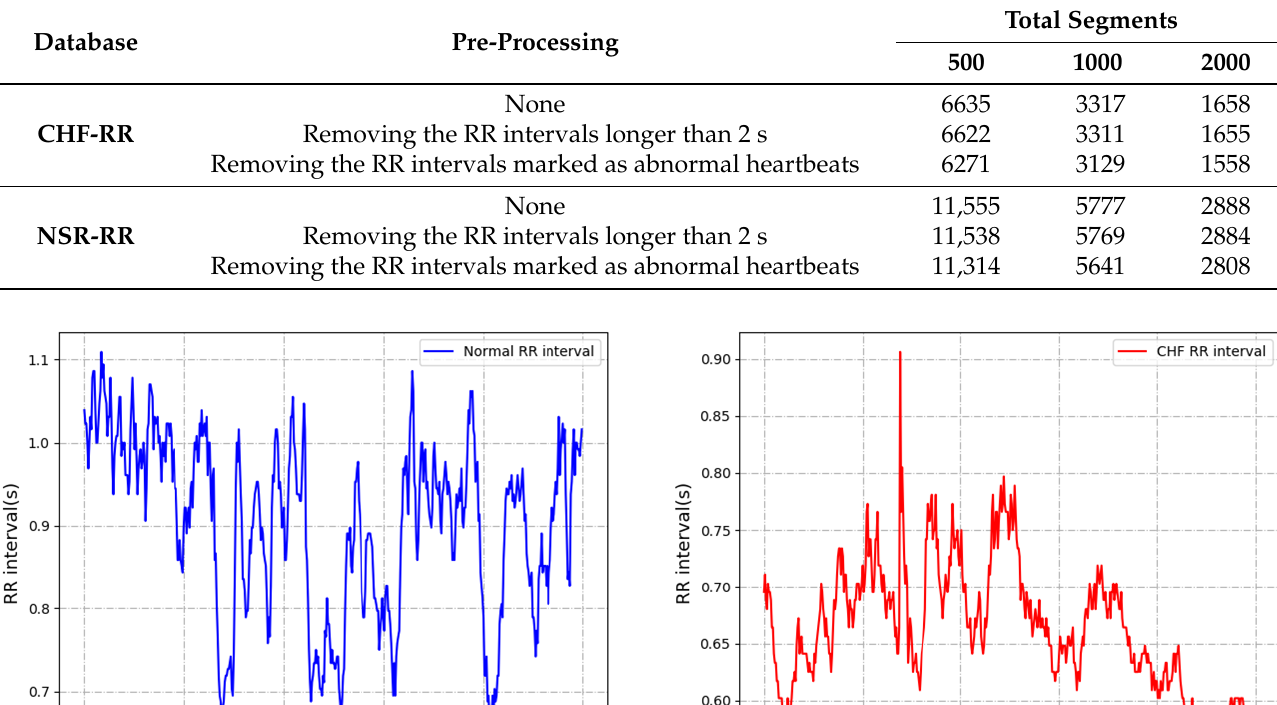
Table 1. The number of signals for different database and classes.